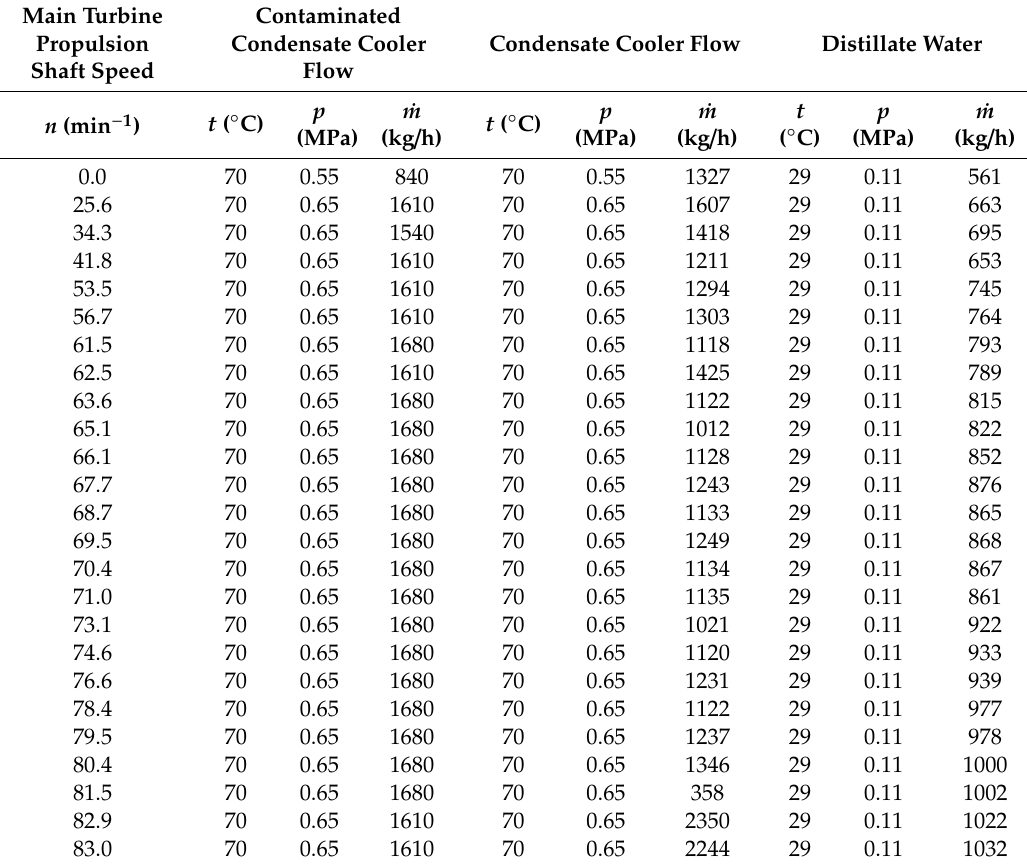
Table A2. Contaminated condensate cooler, condensate cooler and distillate water, temperature and mass data.